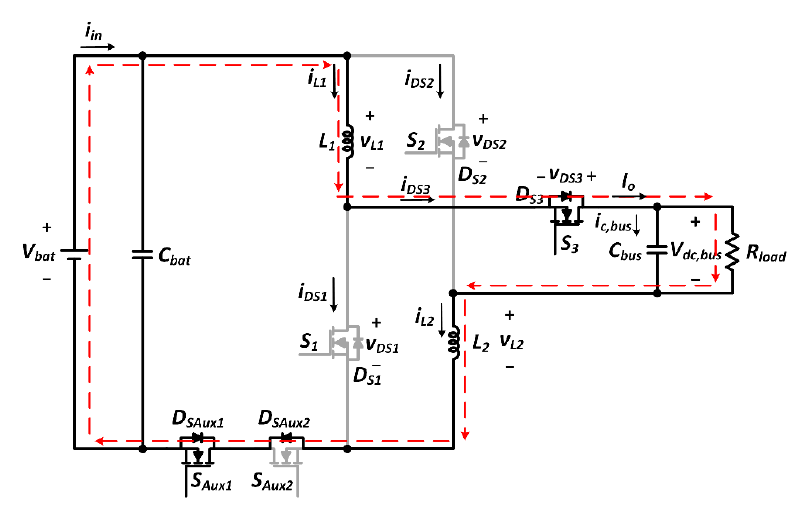
Figure 6. The current flow paths of step-up mode II.